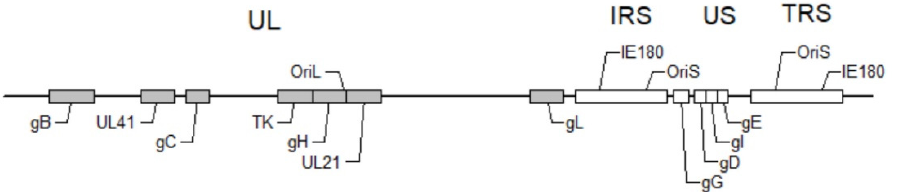
Figure 2. A map of the PRV genome showing the location of PRV genes discussed in this review. The PRV genome consists of the unique long region (UL) and unique short region (US), which is flanked by the internal (IRS) and terminal (TRS) repeat sequences. The genes represented by gray boxes locate in the UL, including gB, UL41, gC, TK, gH, UL21 and gL; the genes represented by white boxes locate in the US, including gG, gD, gI and